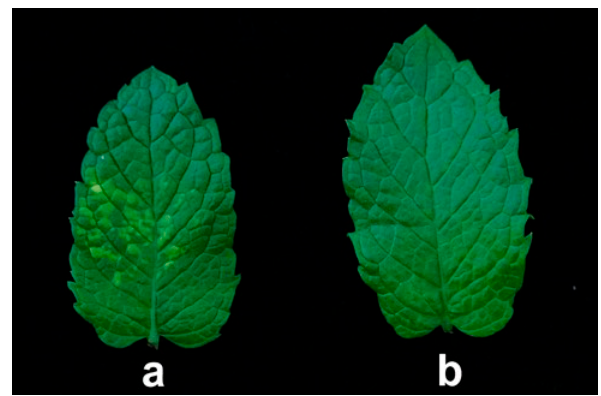
Figure 1. Mentha haplocalyx leaf with mosaic symptoms (a), and symptomless leaf